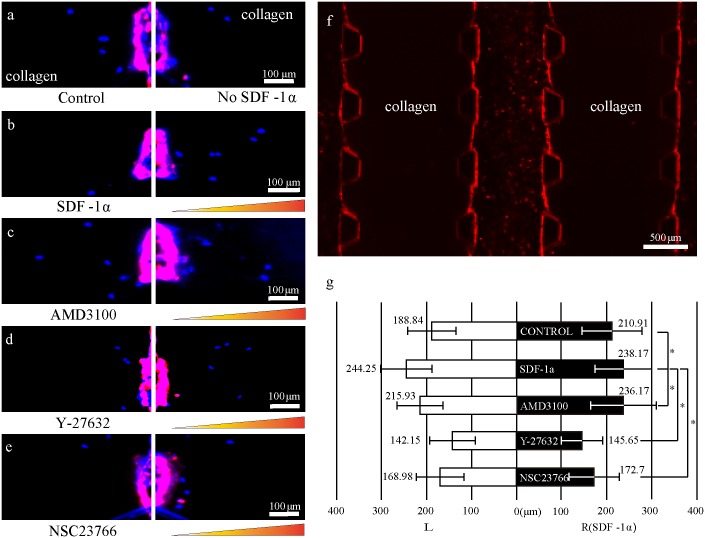
Migration distance of MSCs over the duration of the experiment.Blue dots in the collagen matrix indicate the locations of nuclei of MSCs (a) Control (b) SDF-1α condition. *p>0.05 (c) AMD3100-treated condition. *p>0.05 (d) Y-27632-treated condition. *p<0.05 (e) NSC23766-treated condition. *p<0.05 (f) RFP-expressing endothelial monolayer confluent to the collagen matrix. RFP-expressing ECs are distinguishable from MSCs. (g) Average migration distance of individual MSCs toward or away from the SDF-1α gradient. Graph bars from top to bottom; Control, SDF-1α, AMD3100, Y-27632, NSC23766. Purple and red fluorescence represents endothelial cells. The monolayer near the collagen matrix is shown in purple because of the higher population of ECs along the Z-axis. Orange triangle represents the presence of SDF-1α gradient. F-test was used to compare the average migration of each conditions with the control group. *p<0.05 represents significant variance difference while *p>0.05 represents no significant variance difference. One-way ANOVA analysis for finding inequality group showed *p<0.05.